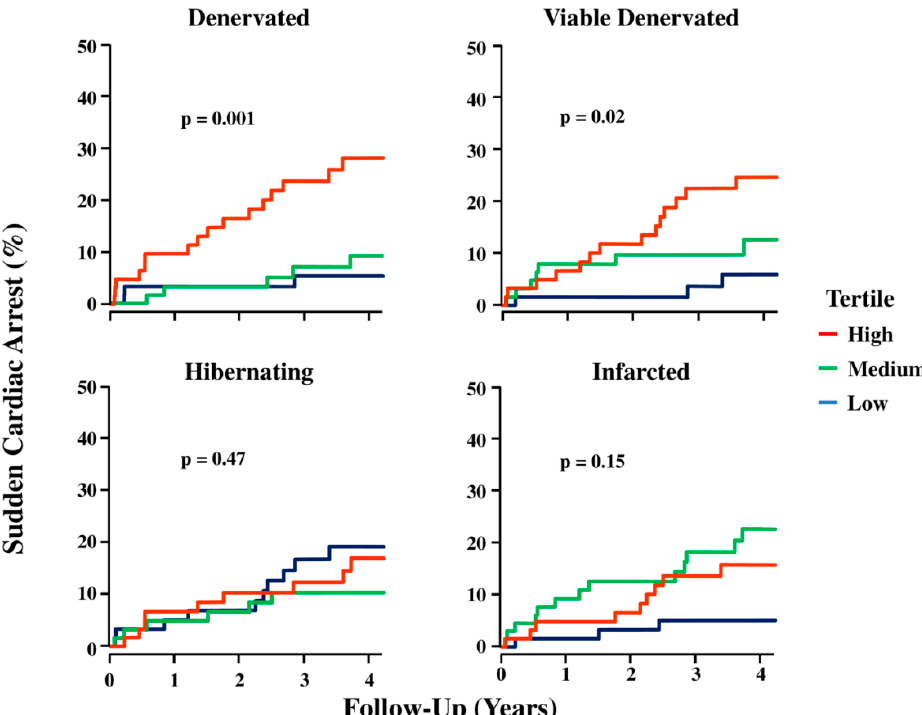
Figure 4. PET parameters and sudden cardiac arrest. Kaplan–Meier curves show the incidence of sudden cardiac arrest for tertiles of PET-defined myocardial substrates (median follow-up 4.1 years). As continuous variables, the total volume of denervated myocardium, as well as viable denervated myocardium, predicted sudden cardiac arrest. Neither infarct volume nor hibernating myocardium was significant as continuous variables. SCA = sudden cardiac arrest [59].